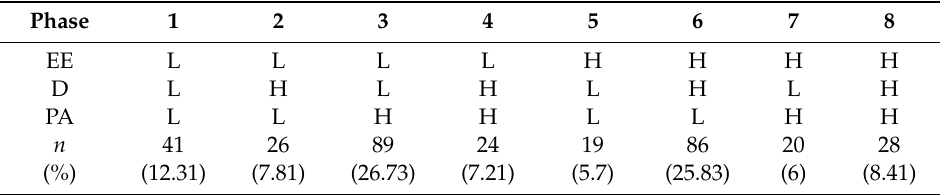
Table 3. Prevalence of burnout according to the stages of the Golembiewski